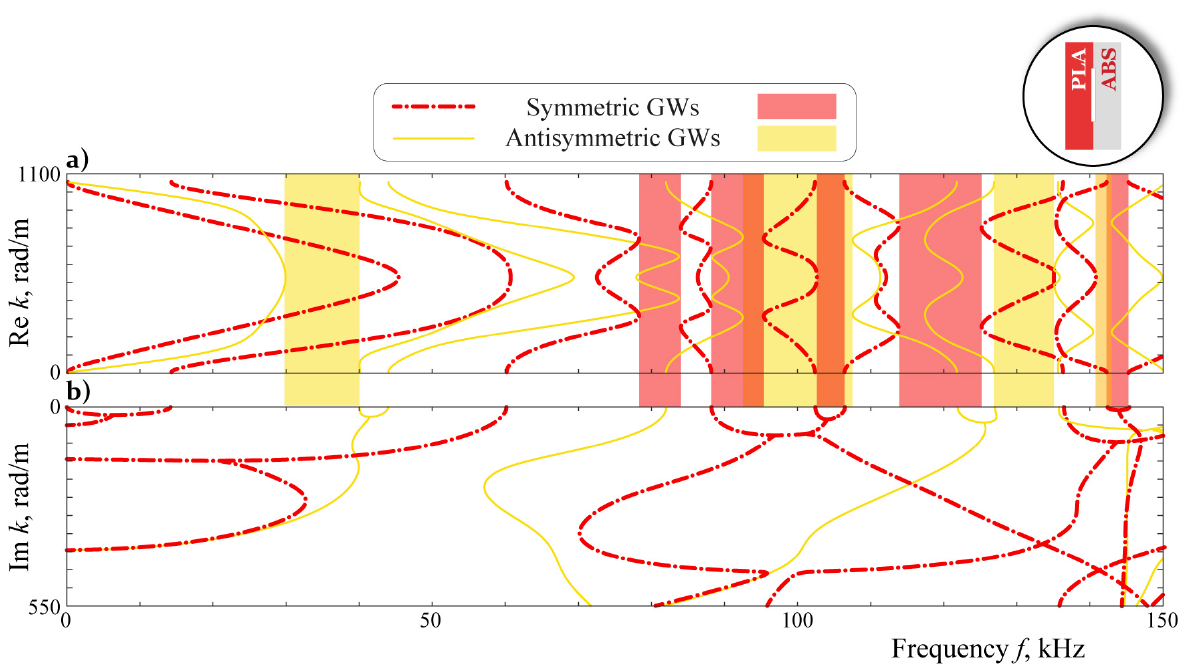
Figure 5. The real ( a ) and imaginary ( b ) parts of the wavenumbers of propagating symmetric and antisymmetric GWs propagating in AMM with central voids.